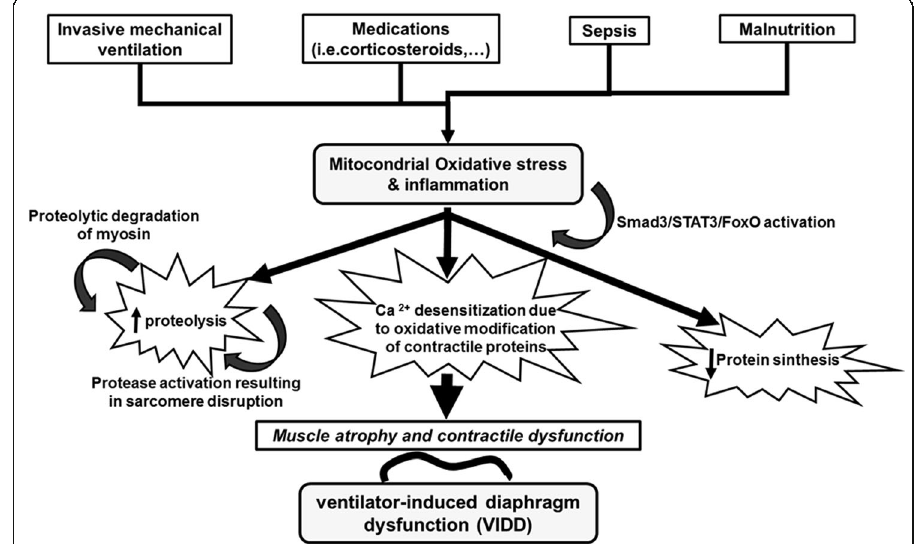
Fig. 1 Summary of the current understanding of the molecular pathways contributing to ventilator-induced diaphragm dysfunction (VIDD) in critically ill patients. As shown, different conditions can lead to